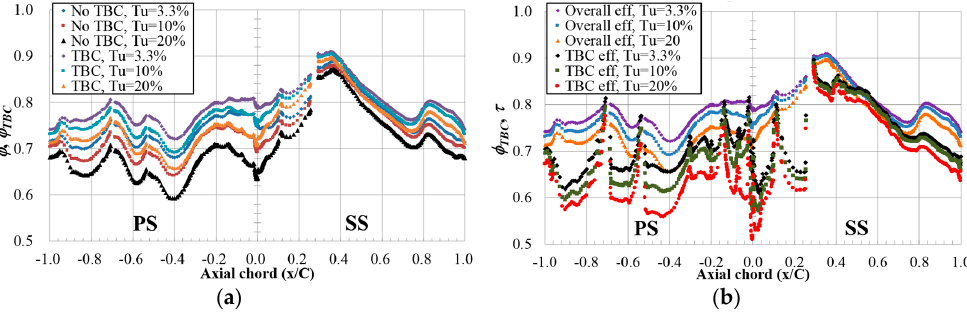
Figure 6. Comparisons between ( a ) overall cooling effectiveness without ( φ ) and with ( φ TBC ) thermal barrier coating; ( b ) φ TBC and TBC effectiveness ( τ ) at midspan and turbulence intensity ( Tu ) = 3.3%, 10% and 20%.